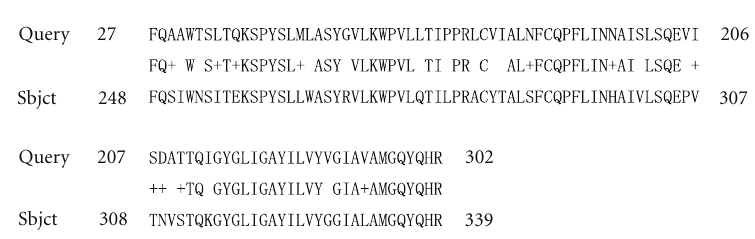
Figure 3: DV548480 shared 73% identity with ABC transporter of Myceliophthora thermophila ATCC